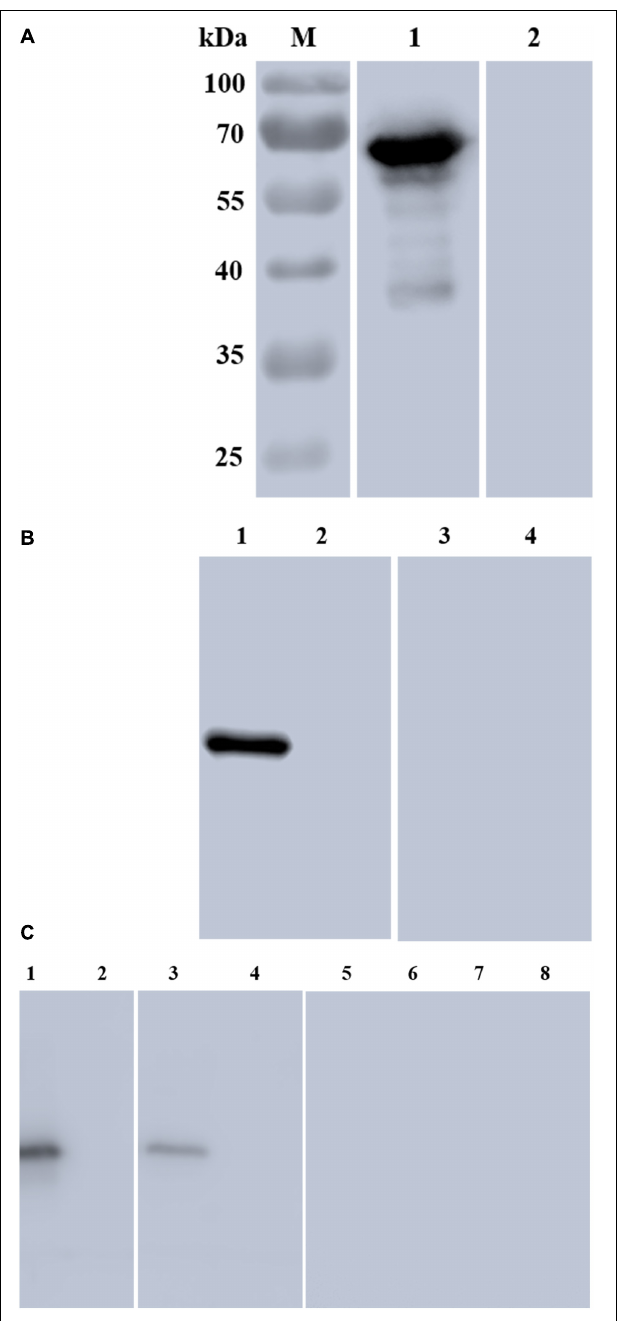
FIGURE 3 | Characterization of rBmSA1 and detection of native BmSA1. (A) Lane M: protein marker; Lane 1: rBmSA1 probed with the serum from B. microti -infected mice; Lane 2: rBmSA1 probed with the serum from normal mice (negative control); (B) Lane 1: lysate of parasites probed with polyclonal anti-BmSA1 antiserum; Lane 2: normal mice RBC lysate probed with polyclonal anti-BmSA1 antiserum; Lanes 3–4: the samples corresponding to 1–2 and probed with the pre-immune serum; (C) Lane 1: parasite lysate standards probed with anti-BmSA1 antiserum; Lane 2: normal RBC lysate probed with anti-BmSA1 antiserum; Lane 3: parasite secretion supernatant probed with anti-BmSA1 antiserum; Lane 4: normal RBC supernatant probed with anti-BmSA1 antiserum; Lanes 5–8: samples corresponding to 1–4 and probed with the pre-immune